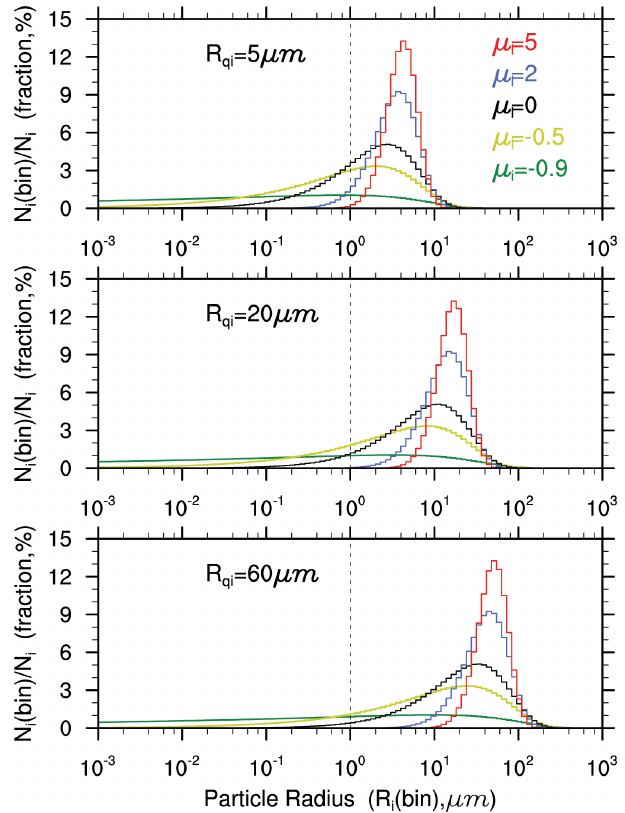
. A total of 100 bins were used here. Each bin i